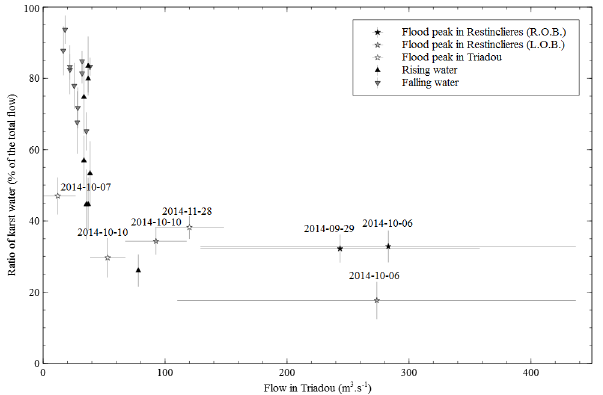
Figure 5. Ratio of karst water in river flow obtained with the dilu- tion law (main flood peaks are indicate by the date of the sampling).